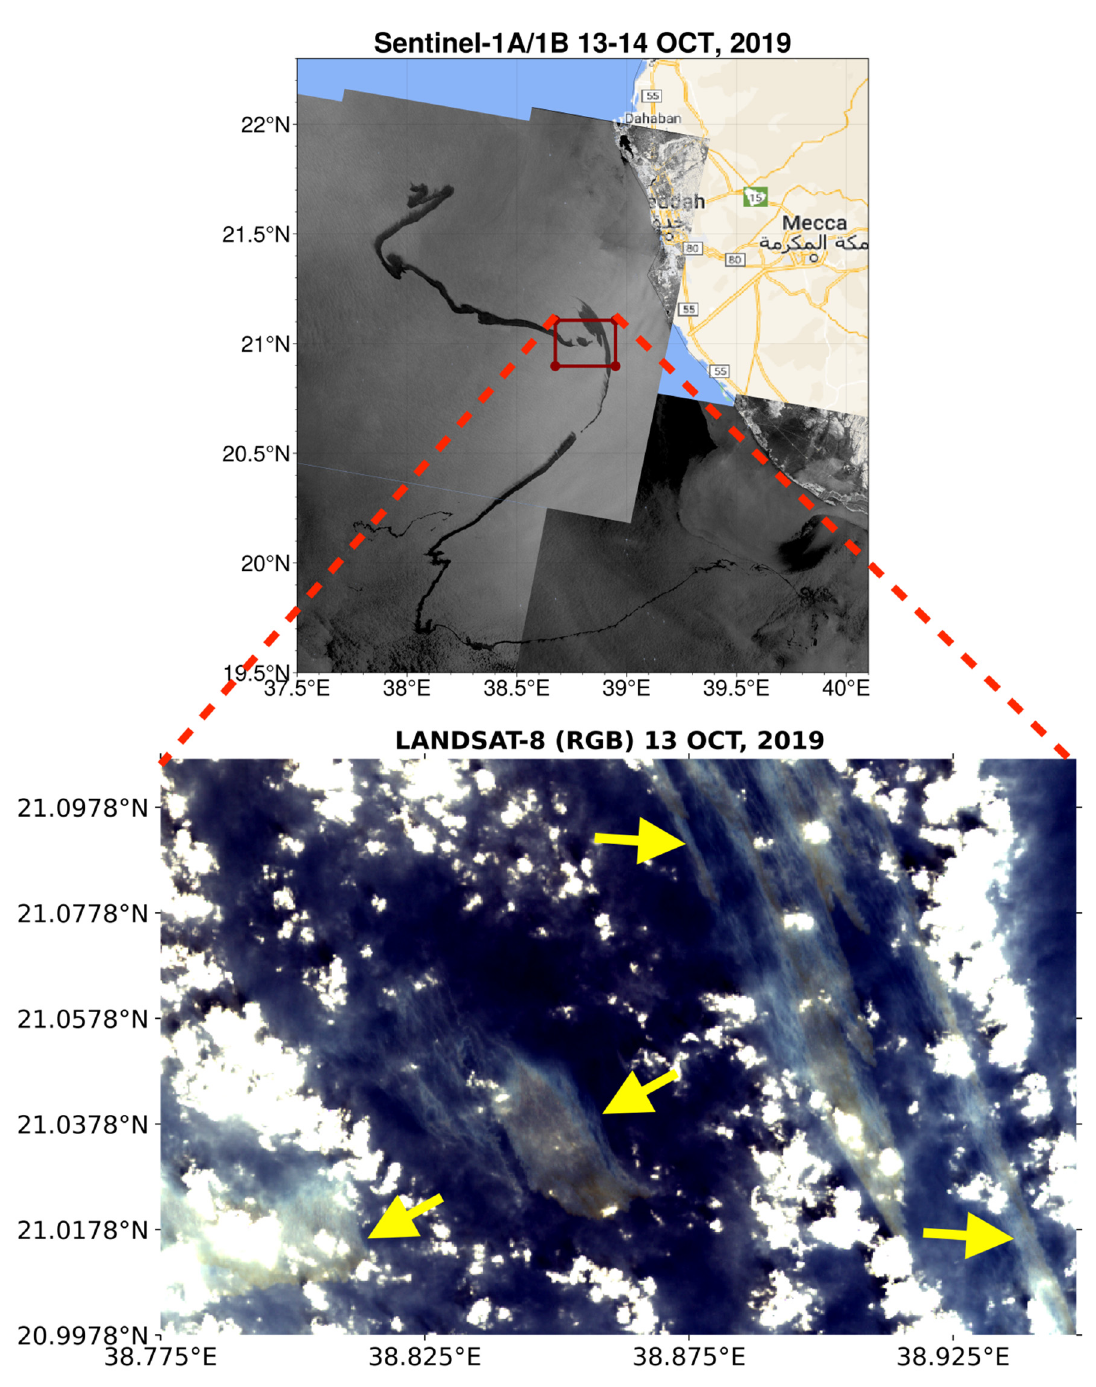
Figure 7. The oil spill using Sentinel-1 imagery on 13 October 2019. The oil-spill using the Lansat-8 OLI visible bands (RGB) composite image was available for the zoomed region of the Sentinel-1 imagery on 13 October 2019. The yellow arrows indicate the oil slicks.